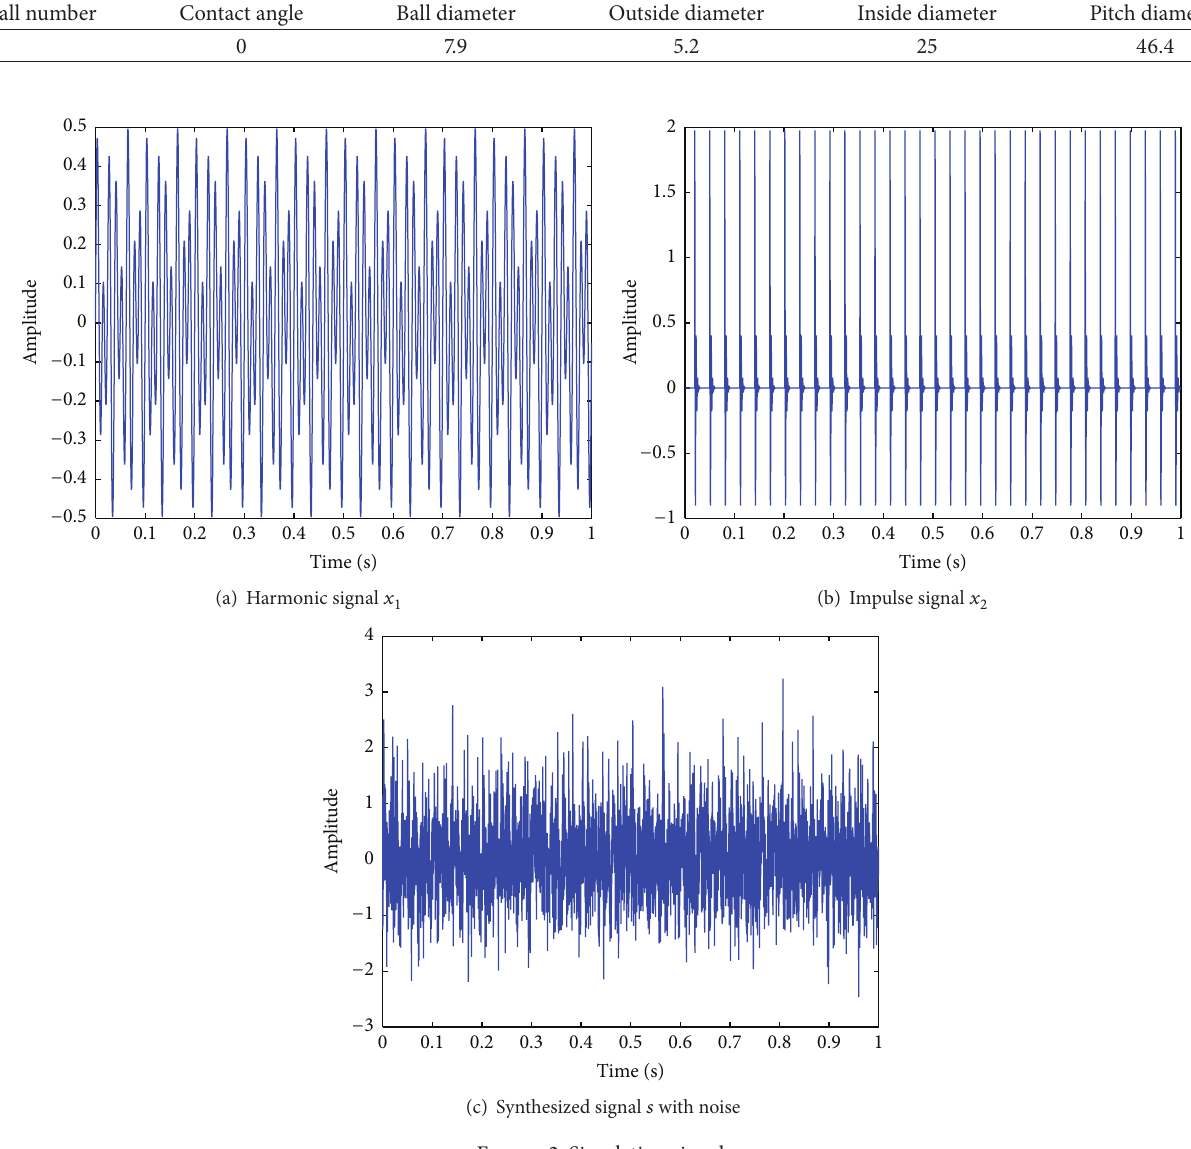
Figure 2: Simulation signal.